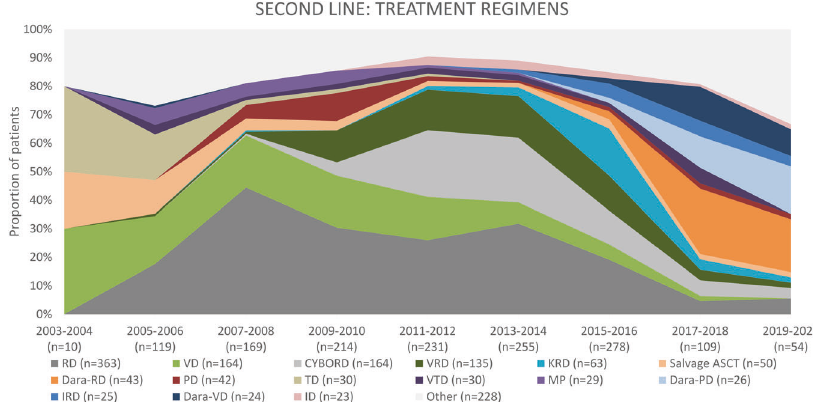
Fig. 2 Most frequently applied second-line treatment regimens in multiple myeloma patients, initiation of second-line treatment 2003 – 2021. CYBORD cyclophosphamide-bortezomib-dexamethasone, D dexamethasone, Dara daratumumab, I ixazomib, K car fi lzomib, MP melphalan-prednisone, P pomalidomide, R lenalidomide, T thalidomide, V